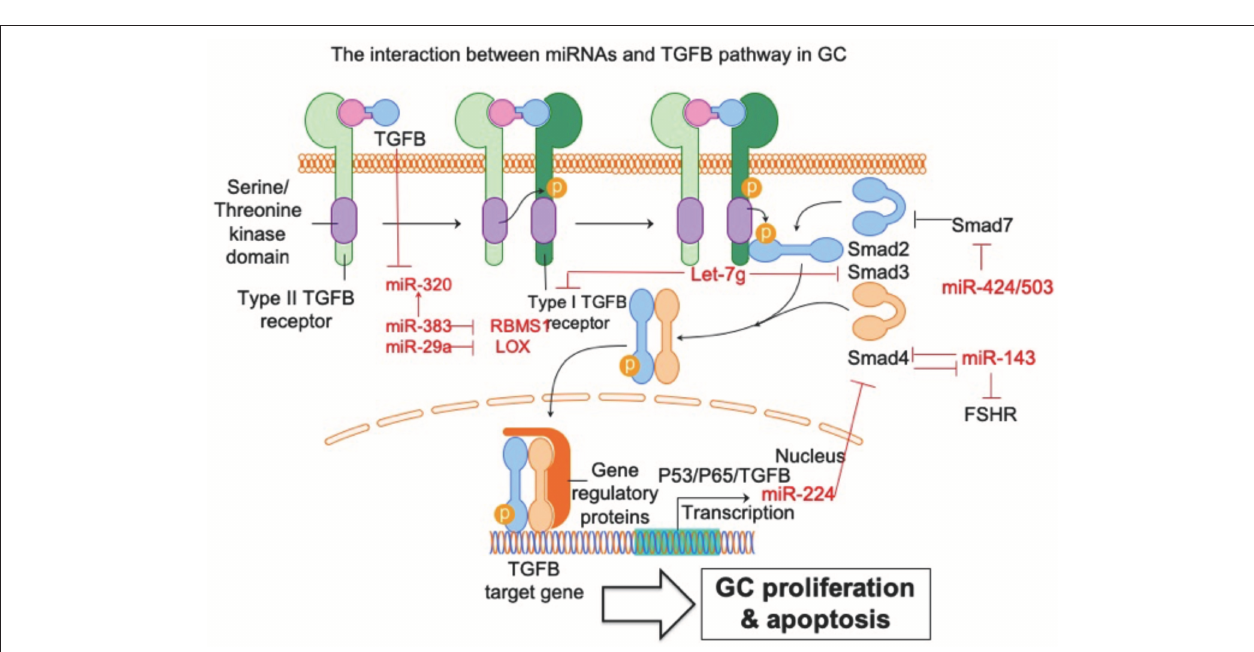
FIGURE 2 | The interaction between miRNAs and TGFB pathway in GC. The interaction of miRNA-TGFB pathway in GC mainly affects the growth and survival of GC in ovary. FSHR, follicle-stimulating hormone receptor; SMAD3, SMAD family member 3; SMAD4, SMAD family member 4; SMAD7, SMAD family member 7; LOX, lysyl oxidase; RBMS1, RNA-binding morif single-stranded-interacting protein 1. Arrowhead line, promotion; Flat-end line,